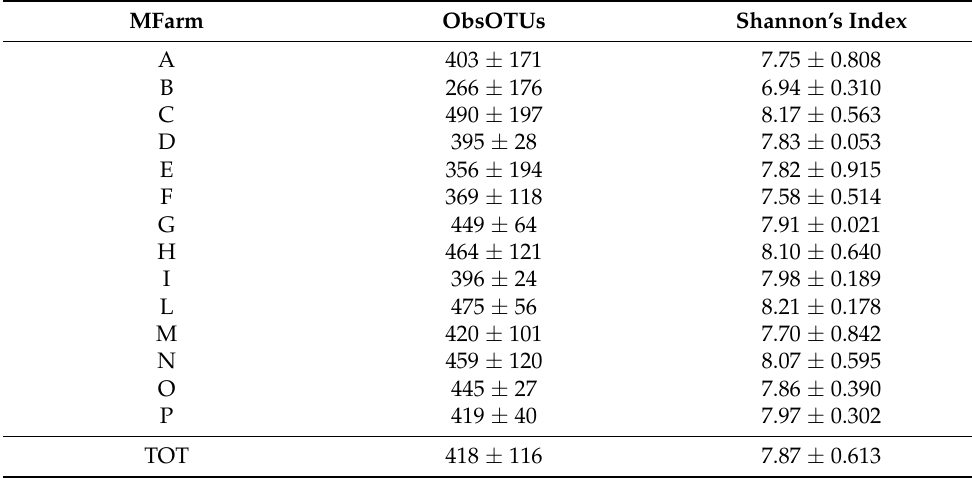
Table 3. Richness (observed Operational Taxonomic Units (OTUs) = ObsOTUs) and Shannon’s diversity index (averages ± standard deviations) of TMB